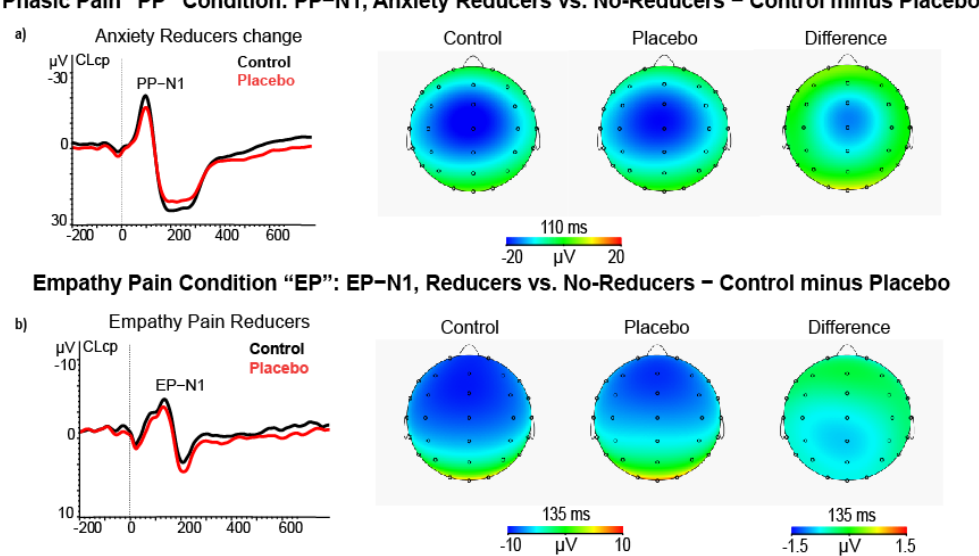
Figure 5. ( a ) ERP, Scalp maps and difference (control minus placebo) maps of PP − N1 amplitude for control and placebo treatments in high state anxiety reducers ( N = 26); ( b ) ERP, Scalp maps, and difference maps of EP − N1 amplitude in other pain reducers ( N = 31) during the empathy pain condition.